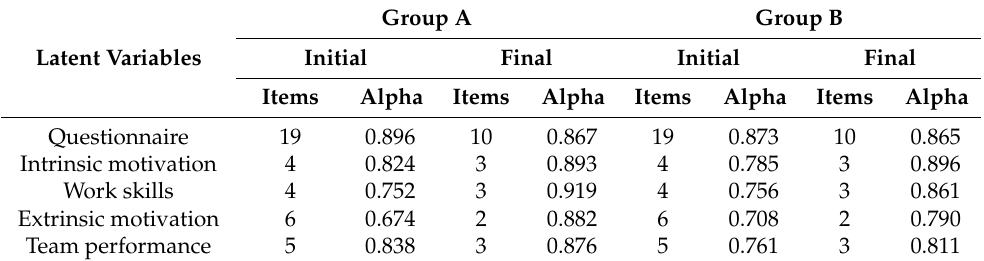
Table 2. Validity and reliability of the test results in the two groups of workers.